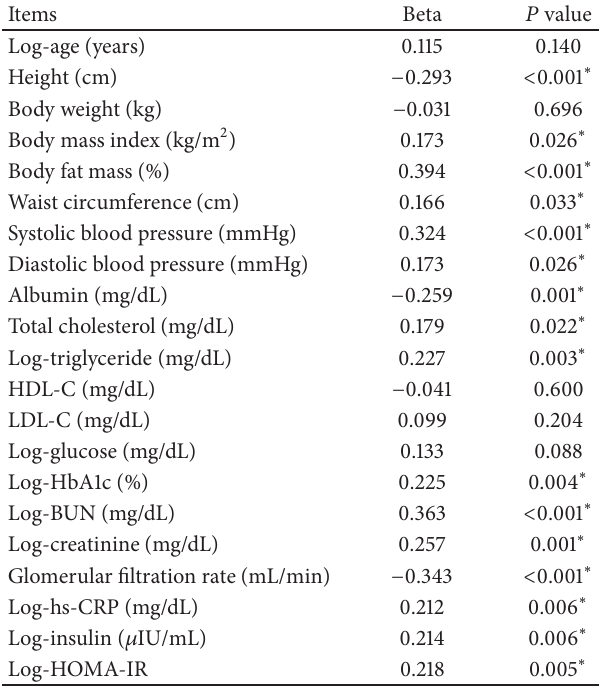
Table 3: Correlation of fasting serum adipocyte fatty acid binding protein levels and clinical variables by univariable linear regression analyses among the 165 diabetic